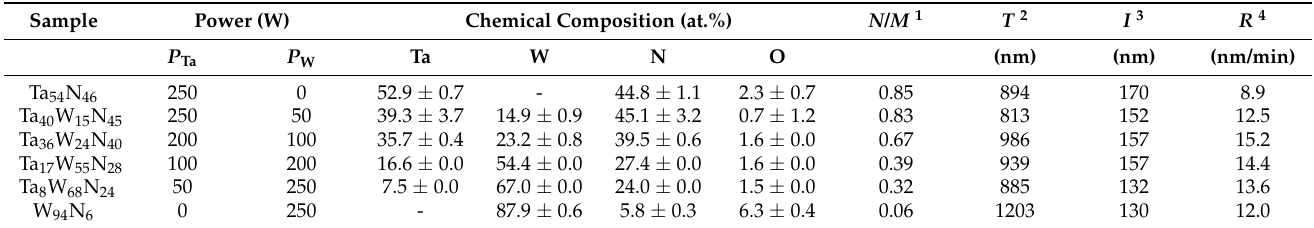
Table 1. Sputtering parameters, chemical compositions, and thicknesses of the TaWN